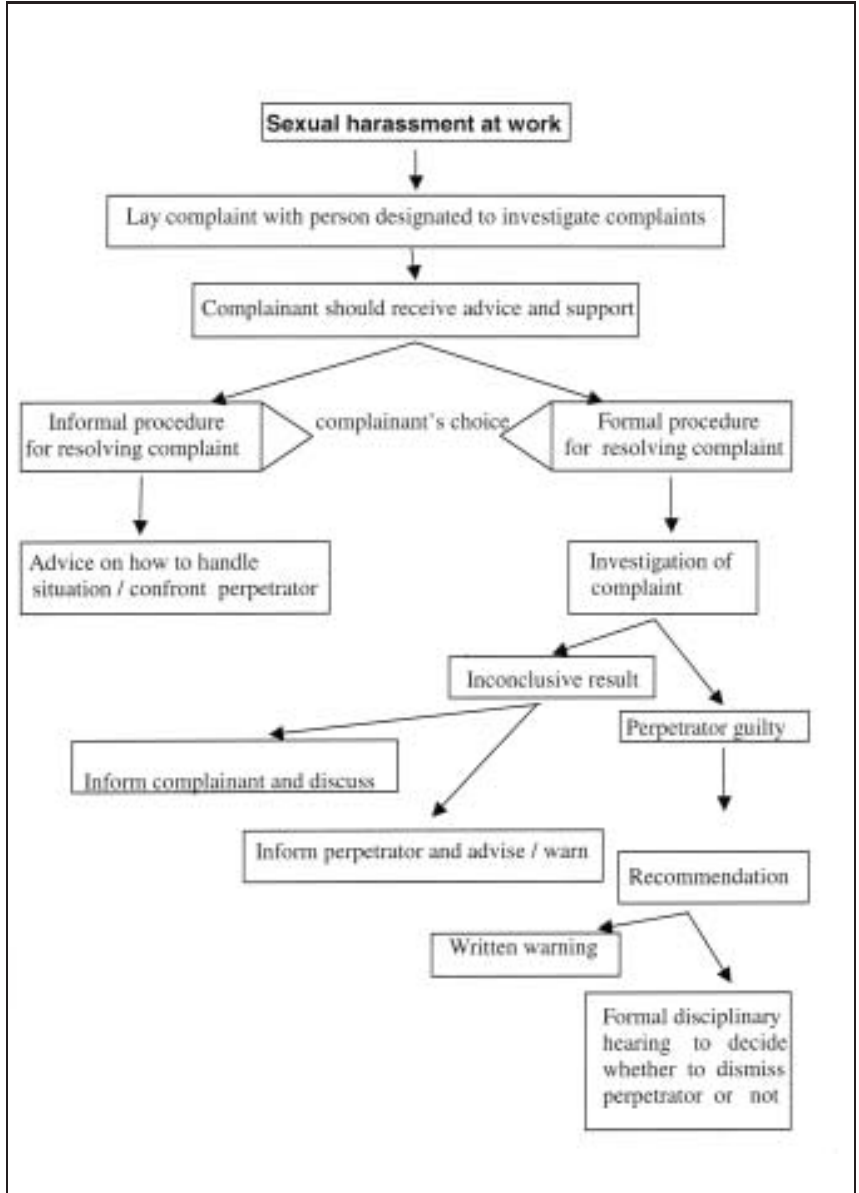
Figure 1: Summary of guidelines (Tables 1 and 2) for management of sexual harassment in the